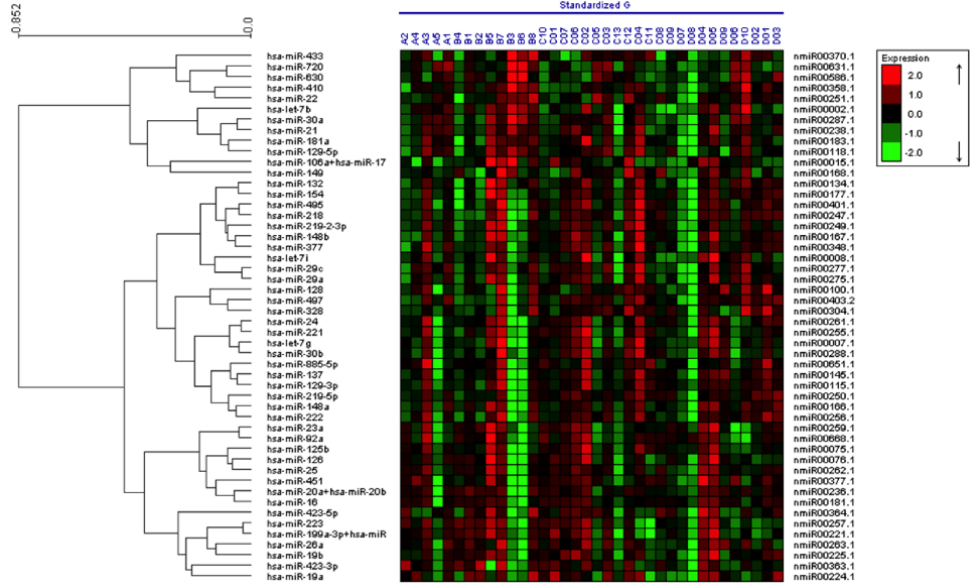
Figure 1. Characterization of miRNA expression in plasma-derived exosomes from individuals with a genetic predisposition to melanoma (all inclusive), spouse controls and patients with sporadic metastatic melanoma. RNA was prepared from plasma-derived exosomes from the patient cohorts listed in Table 1, and miRNA expression profiling was conducted on the nCounter Analysis System using the human V1 miRNA assay kit. Table 2. Primers used for miRNA expression.